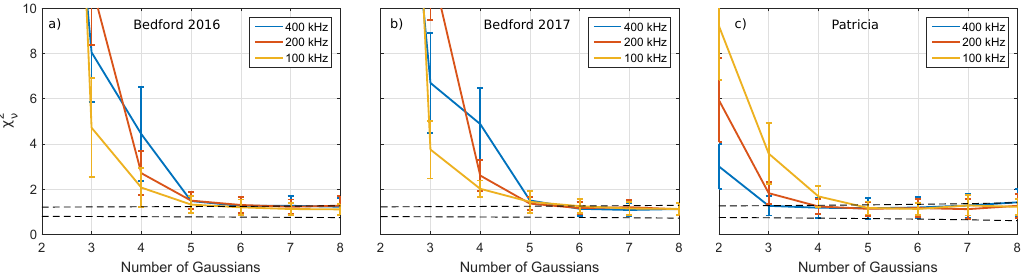
Figure 6. Chi-square test applied to the ( a ) Bedford 2016, ( b ) Bedford 2017, and ( c ) Patricia Bay dataset for incident angles from 40 ◦ to 60 ◦ of the starboard and port side. The solid lines and their error bars represent the mean and standard deviation of the reduced- χ 2 values of all considered angles. The black √ dashed lines show the reduced- χ 2 value of 1 ± 2/ ν , which indicates a good model fit (see Section 3.3).